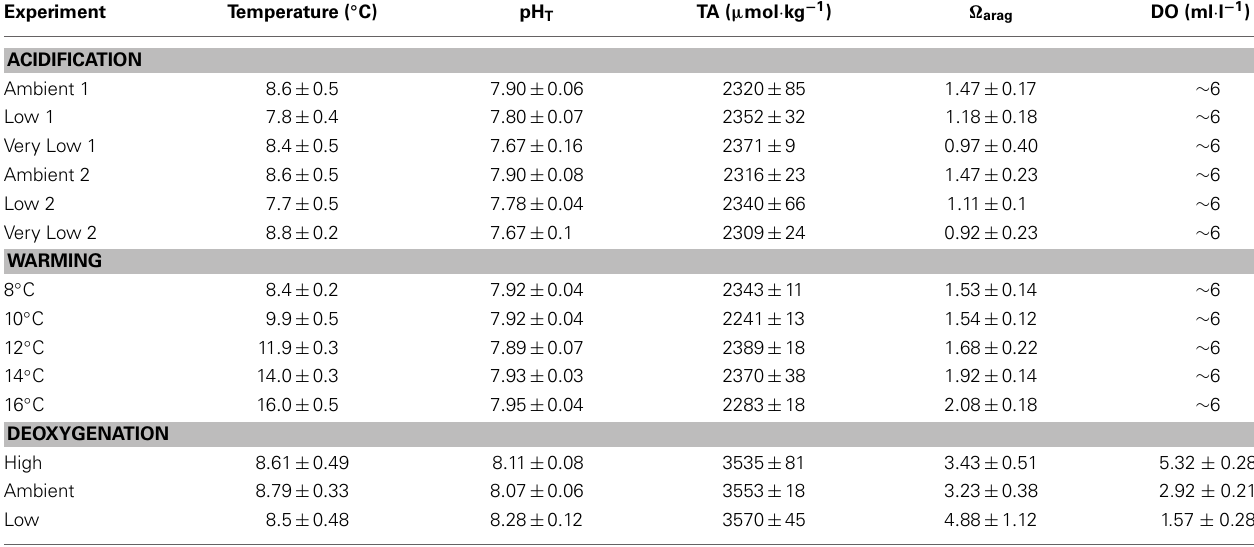
Table 1 | Tank conditions for the different experiments.